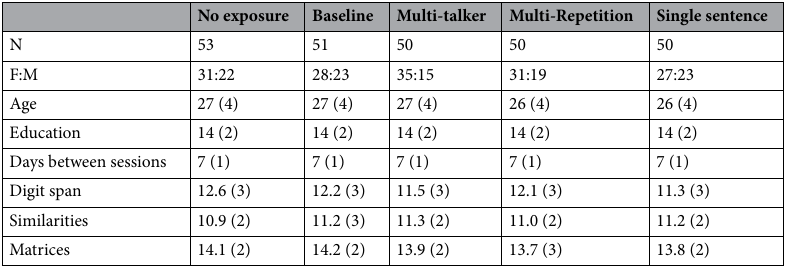
Table 4. Group characteristics—mean (SD). Education is given in years. For Digit span, Similarities and Matrices scaled scores are